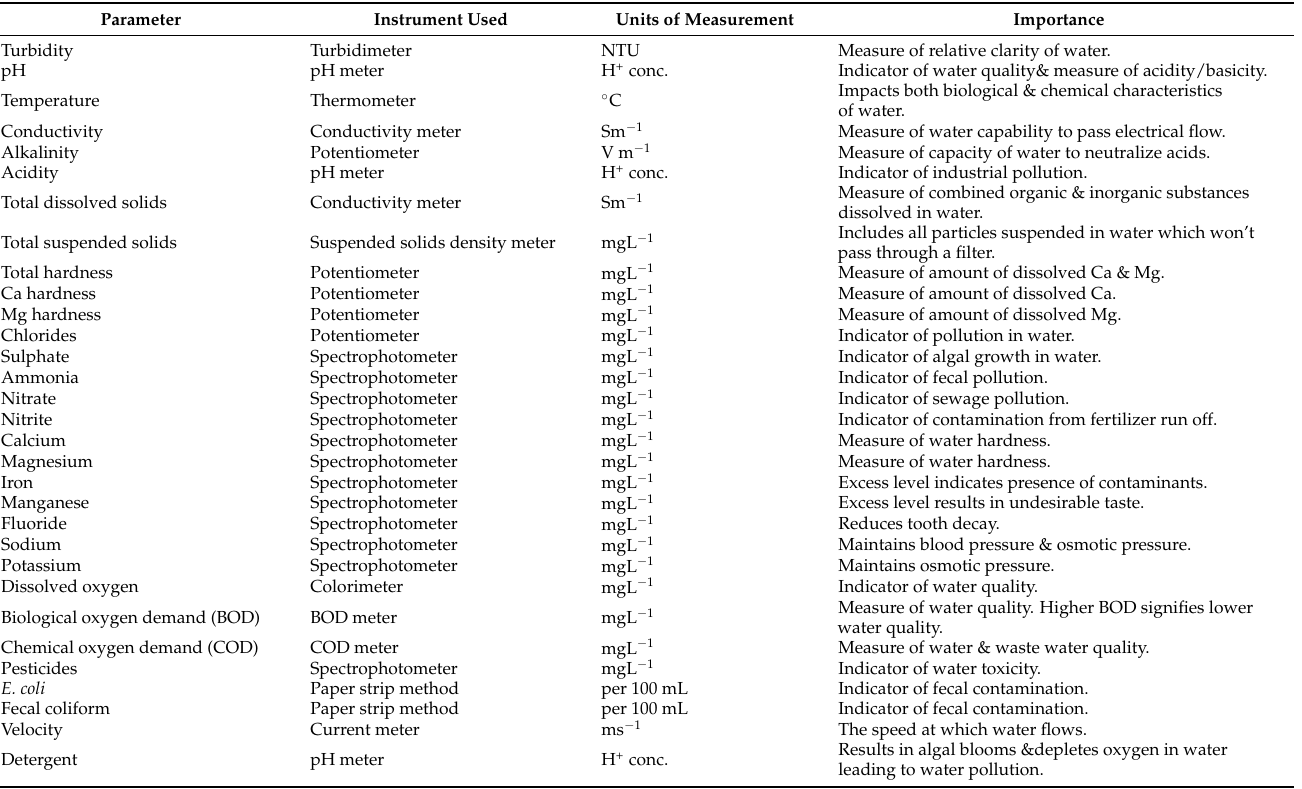
Table 1. Parameters to be considered while treating